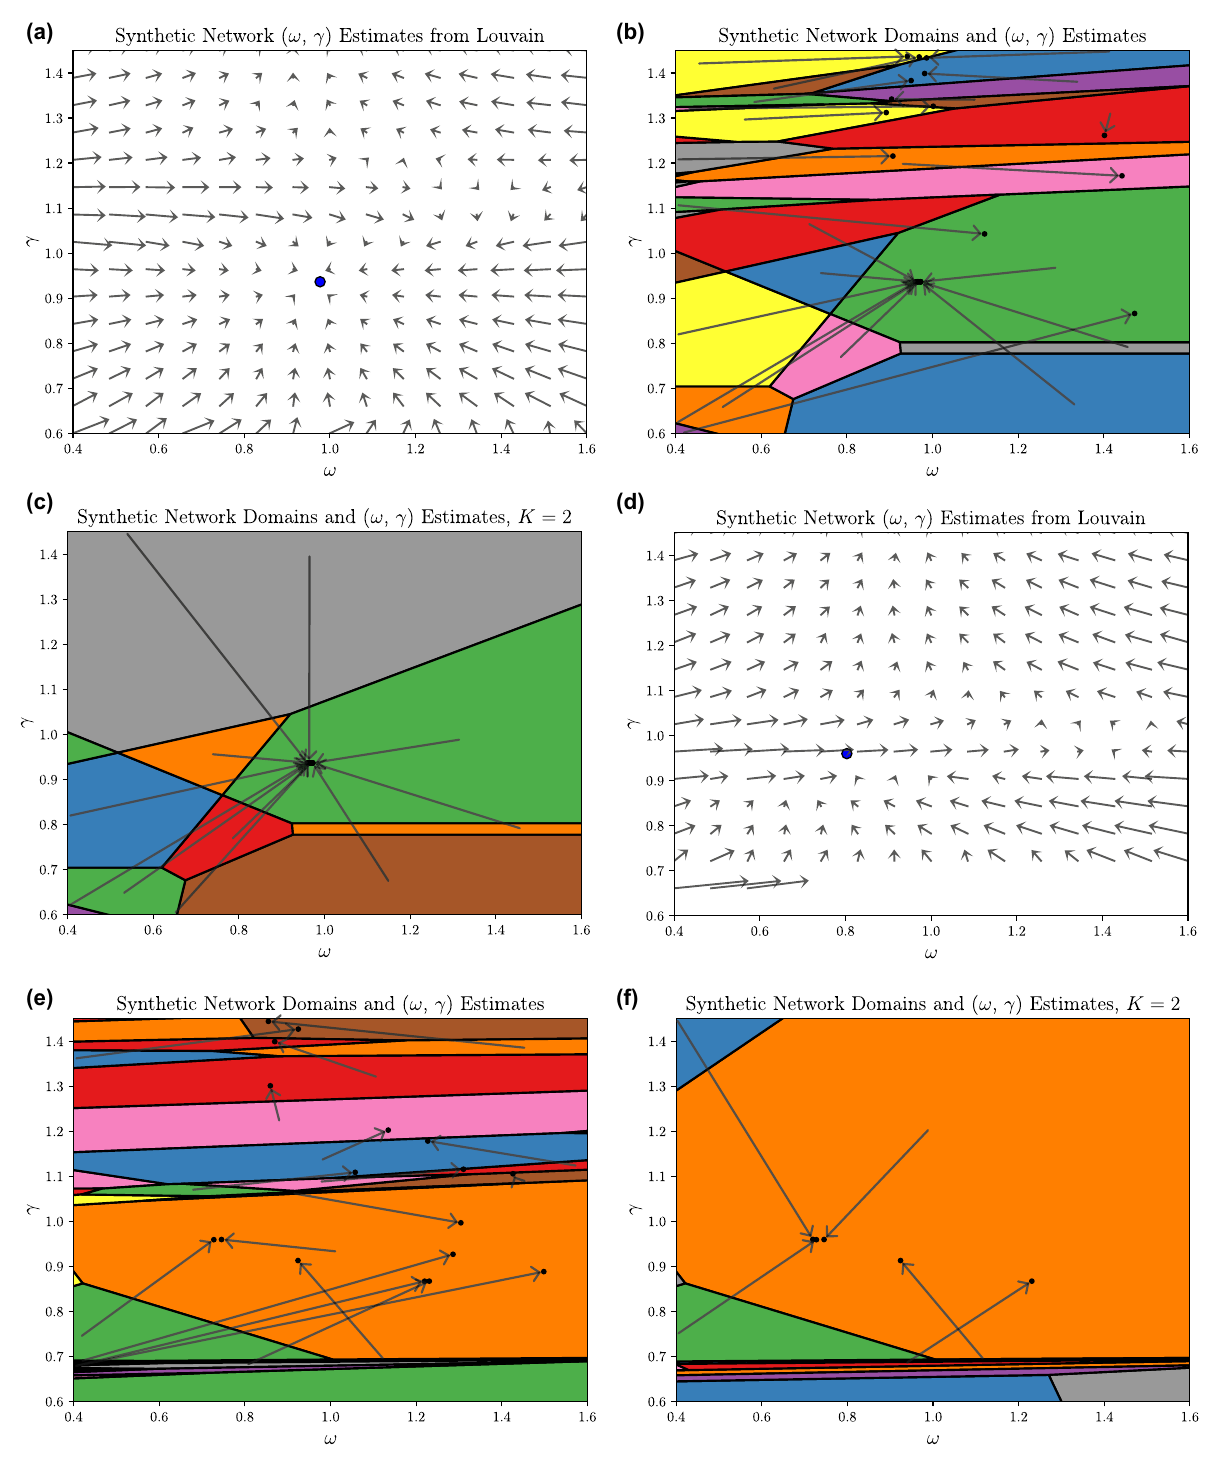
Figure 4. Comparing different iterative procedures on synthetic multilayer networks. Top row: the Pamfil et al. 18 “easy” regime. ( a ) The Pamfil et al. iterative map visualized on an (ω , γ) grid with arrows (scaled down 10%) indicating the direction of parameter estimates using Louvain at each (ω , γ) , averaged over five trials, finding a stable fixed point near the blue point from the ground-truth partition, (ω , γ) ≈ ( 0.98, 0.94 ) . ( b ) Domains of optimality for the CHAMP set ( ≈ 25 partitions somewhere optimal in the displayed range), with arrows from the centroid of each domain to its (ω , γ) estimate. ( c ) Domains of optimality and (ω , γ) estimates from CHAMP restricted to K = 2 communities. Bottom row: the Pamfil et al. “hard” regime: ( d ) The ground- truth (ω , γ) ≈ ( 0.80, 0.96 ) blue point is unstable under the Pamfil et al. iterative map, whereas the finite state maps on ( e ) the full CHAMP set and ( f ) restricting CHAMP to K = 2 communities both identify a fixed point near the ground-truth estimates. The absence of arrows for γ (cid:31) 0.65 are from the single-community